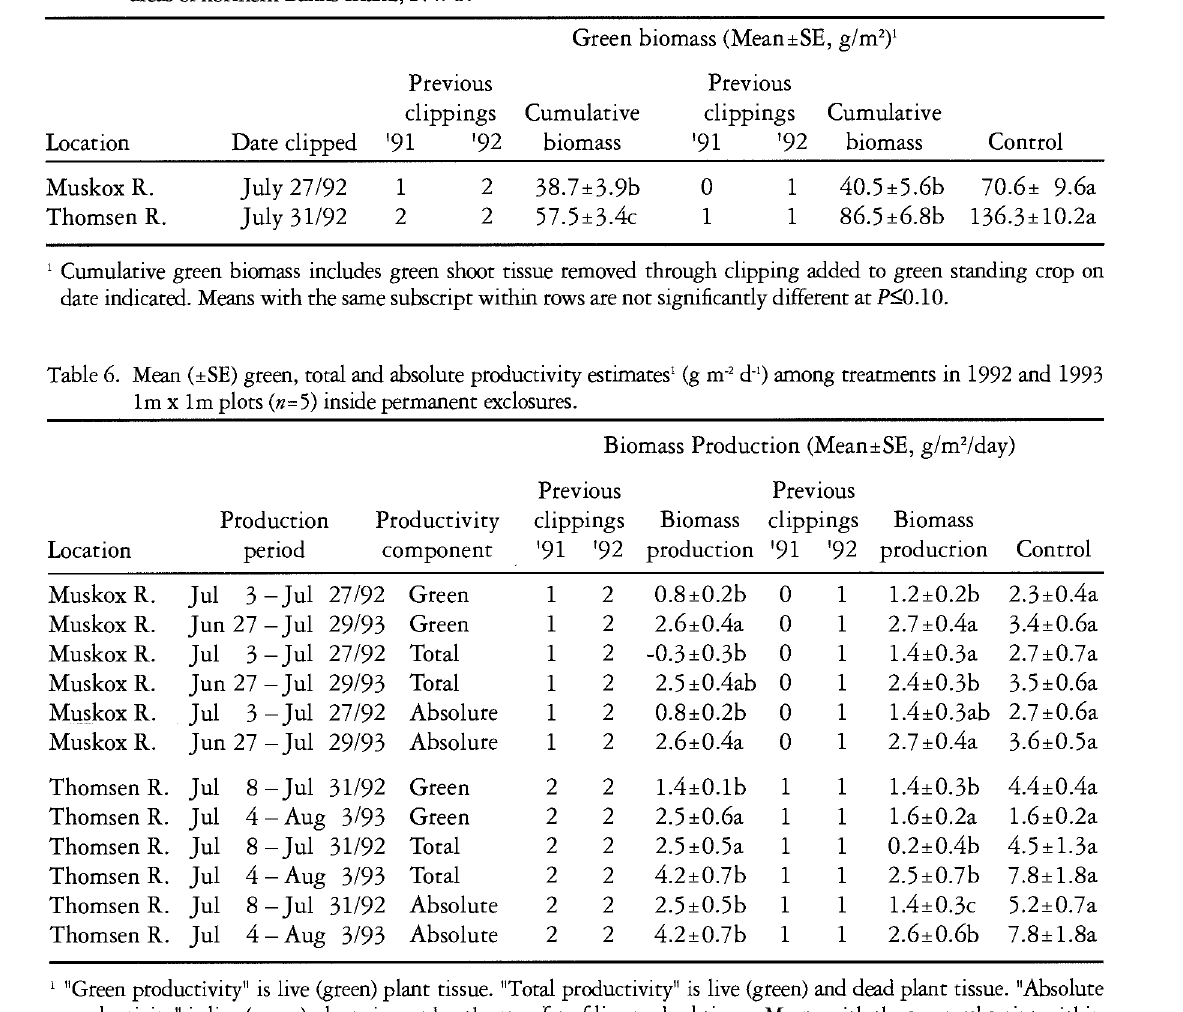
Table 5. Cumulative production of green biomass at 2-5 clippings over 1 and 2 growing seasons and in controls at 2 areas of northern Banks Island, N W T.